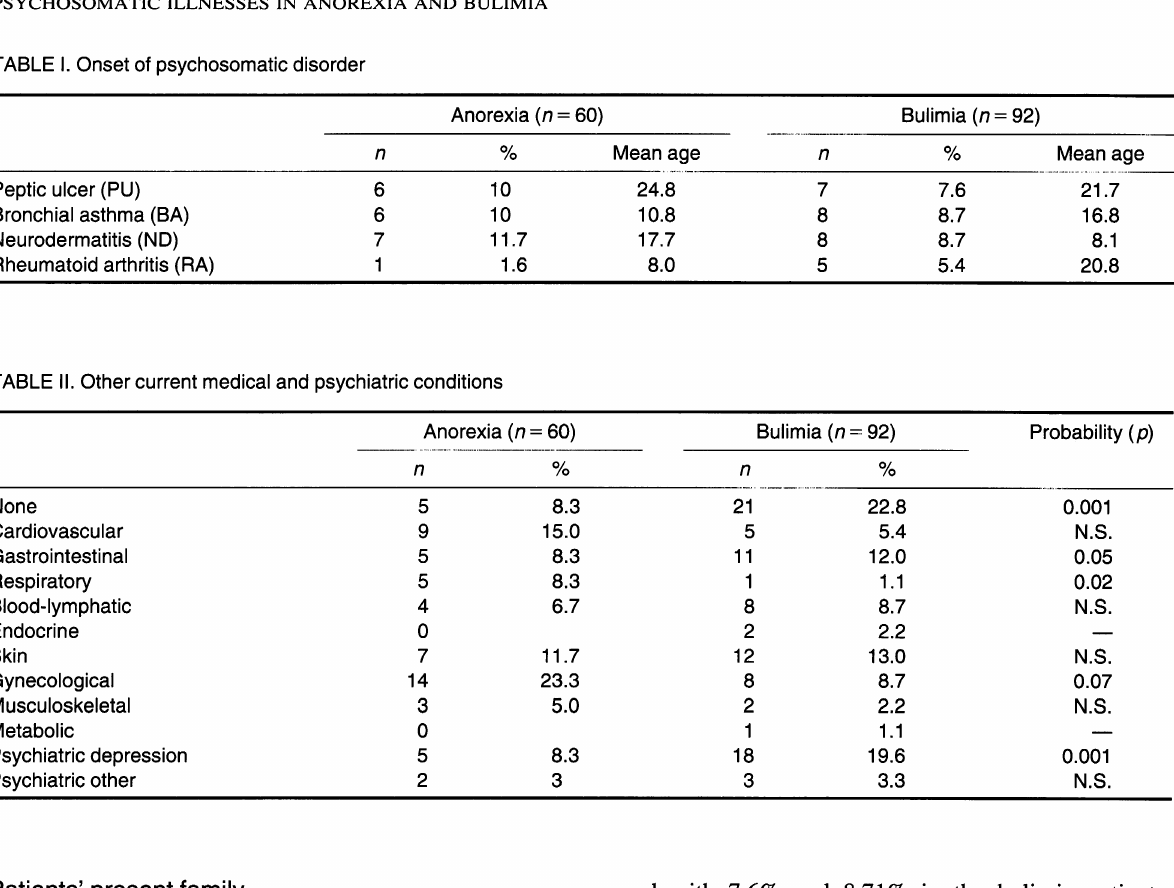
TABLE I. Onset of psychosomatic disorder